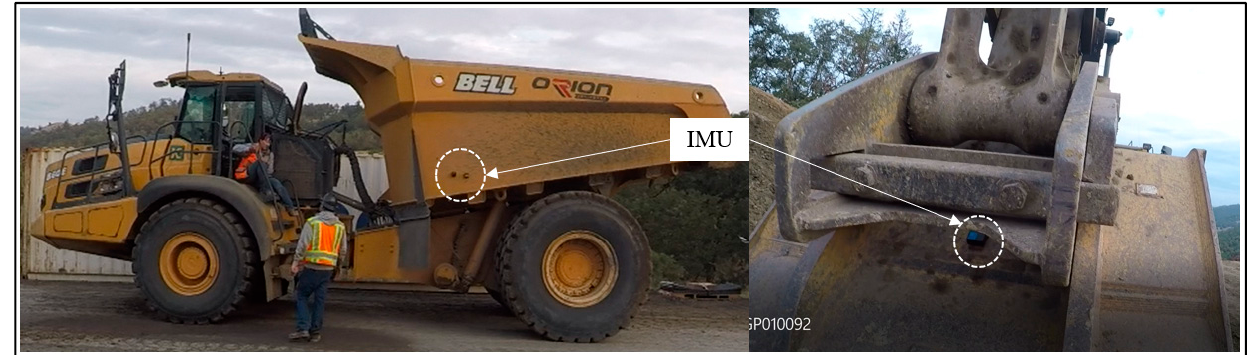
Figure 6. IMU attachment to dump truck and excavator.